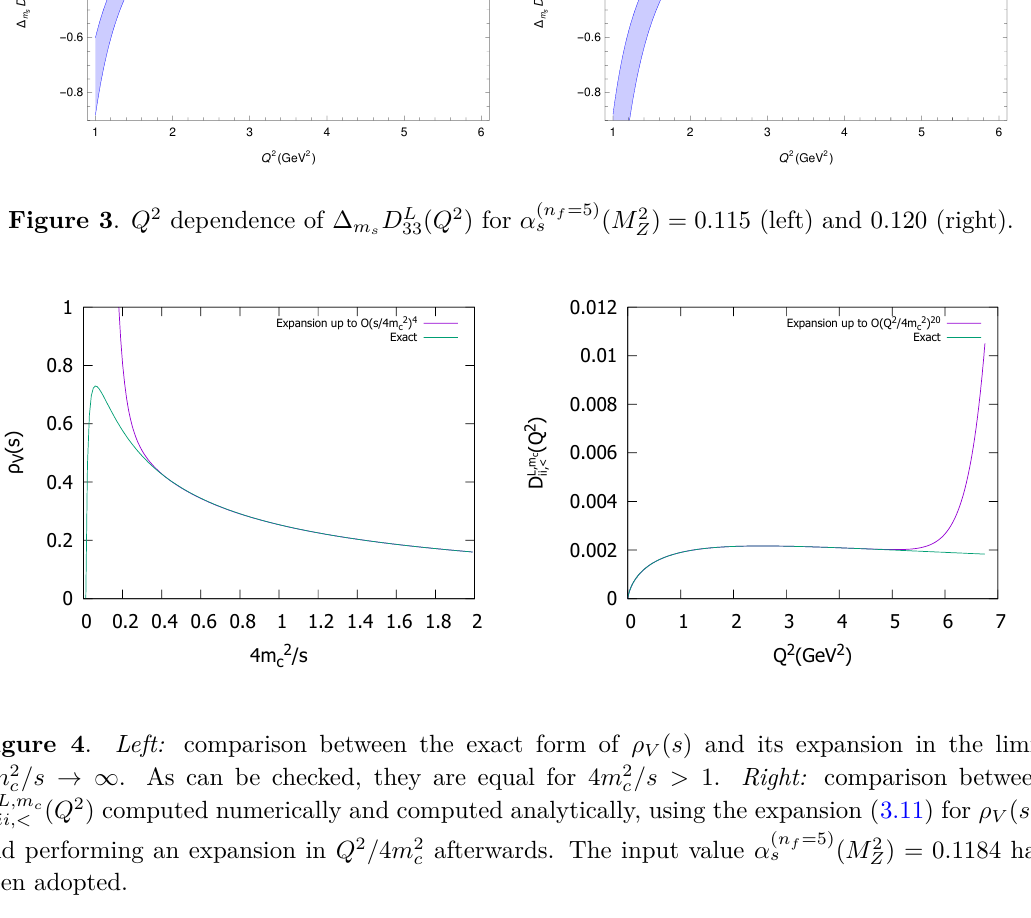
/s > 1 . Right: comparison between c afterwards. The input value α ( n f =5) s ( M 2 ) = 0 . 1184 has c Z